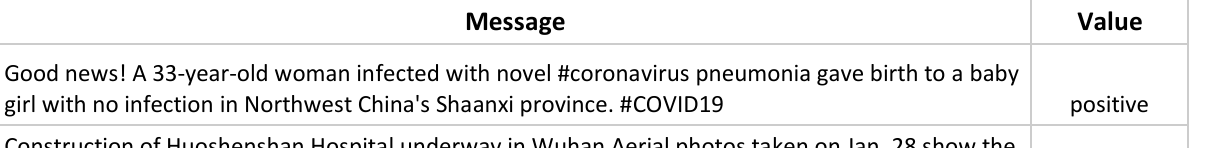
Table 1 : Chinese state media